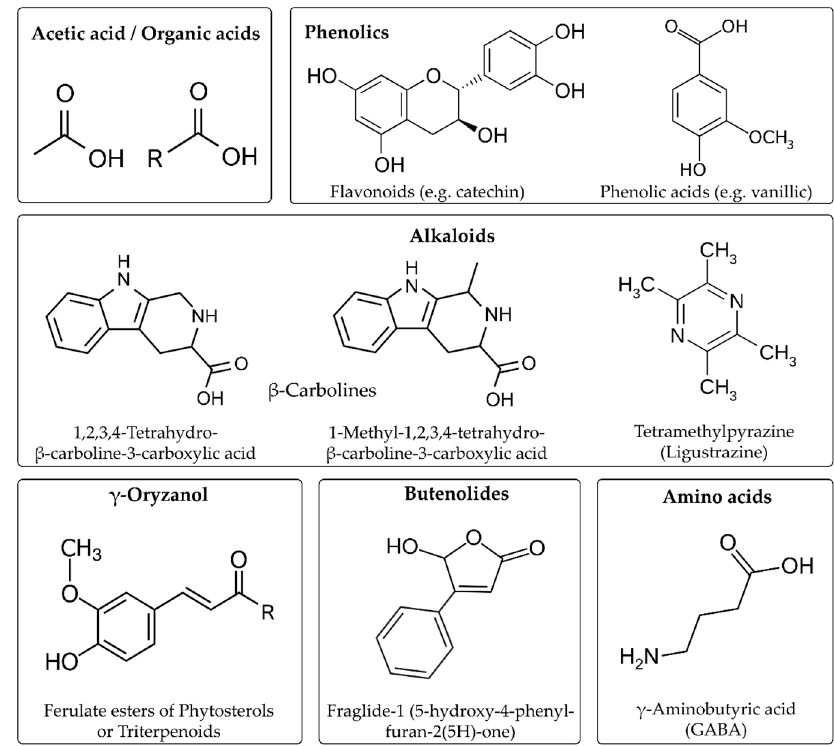
Figure 1. Important bioactive components in cereals and cereal vinegars.